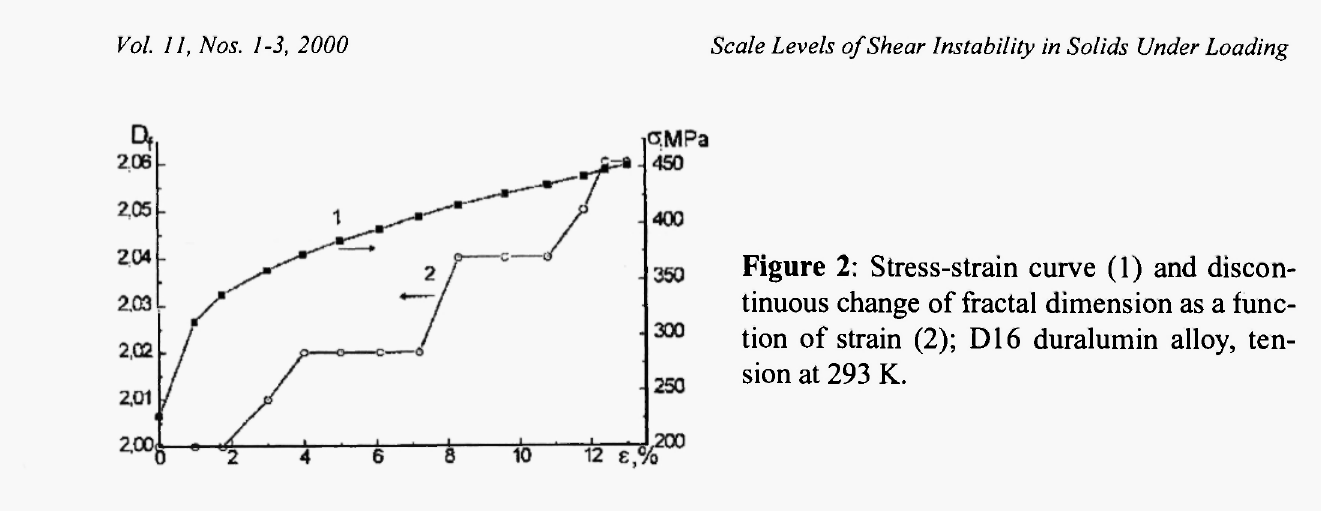
Figure 2: Stress-strain curve (1) and discon- tinuous change of fractal dimension as a func- tion of strain (2); D16 duralumin alloy, ten- sion at 293